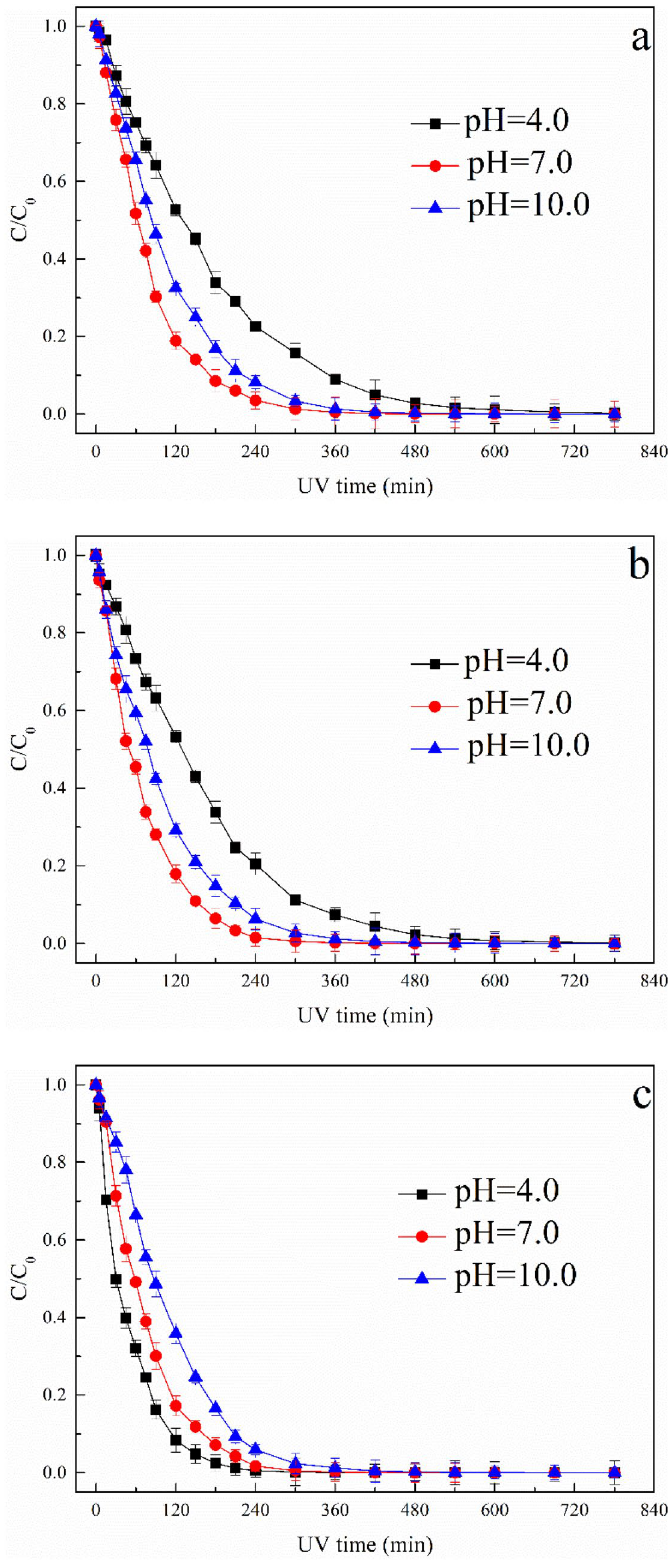
Figure 1. Effect of solution pH on ATZ removal: ( a ) UV process; ( b ) UV/H 2 O 2 process; ( c ) UV/TiO 2